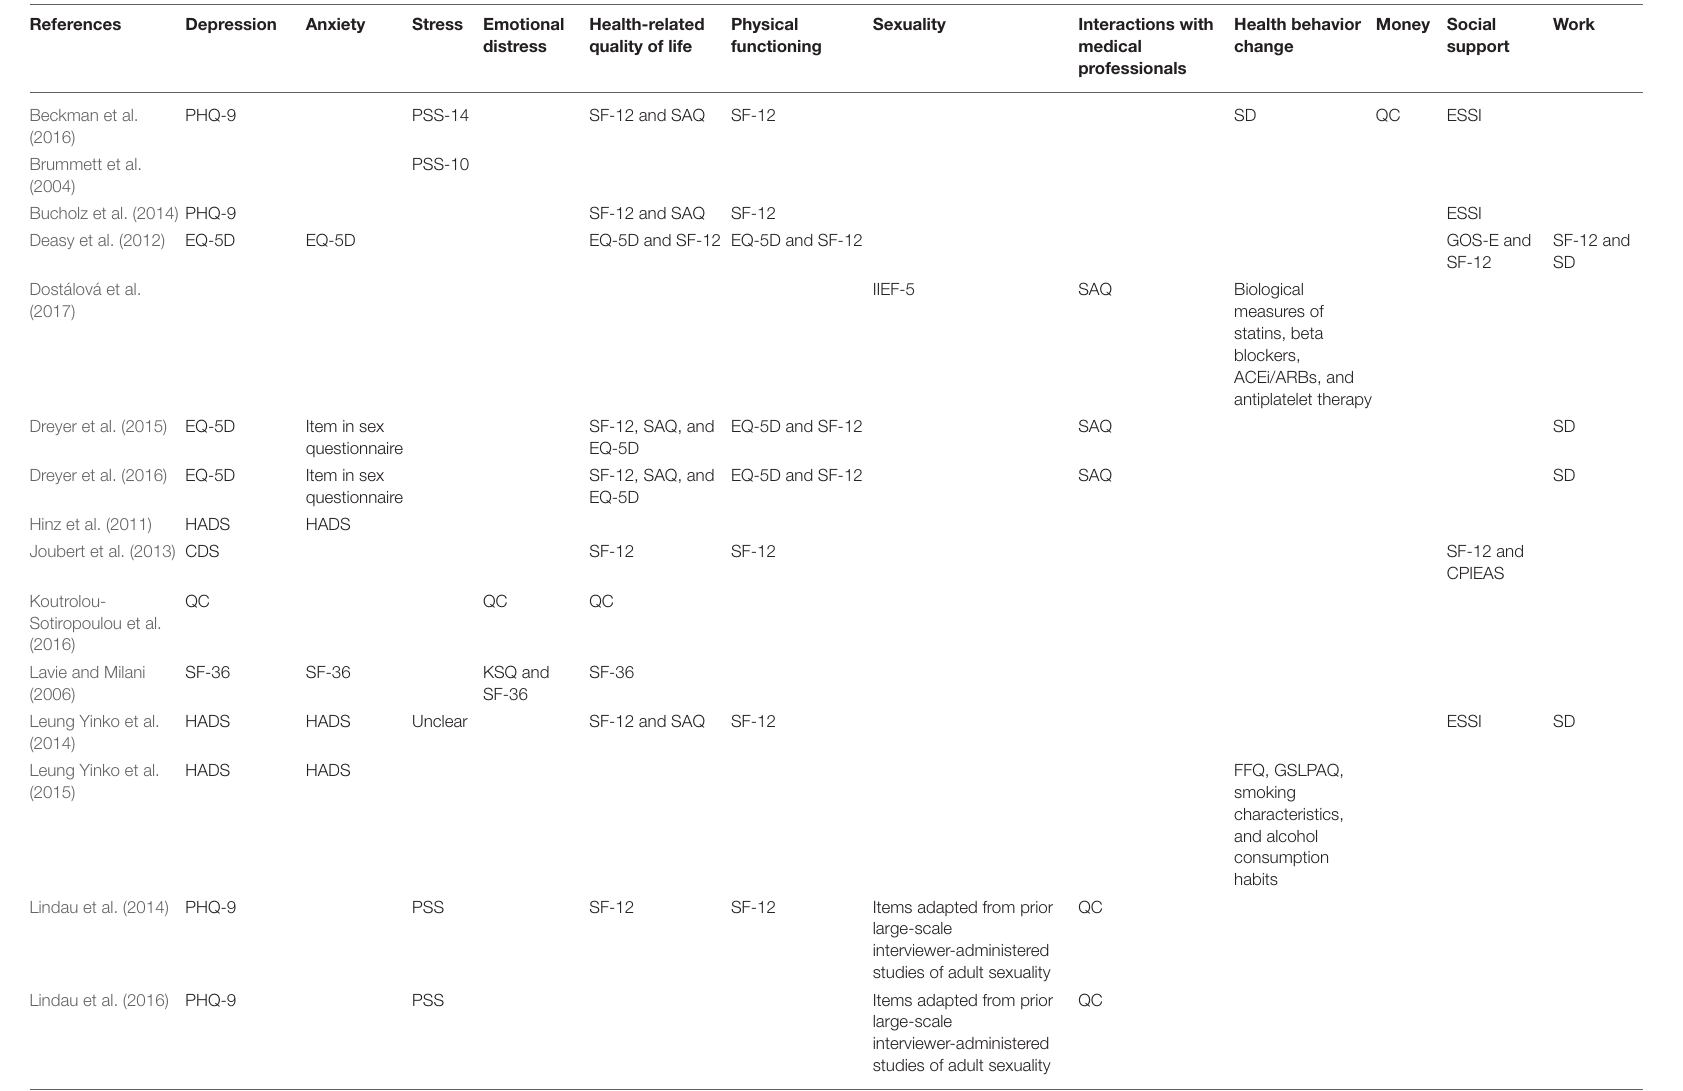
TABLE 3 | Questionnaires used in each quantitative